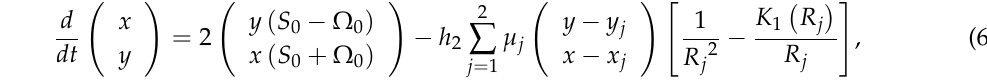
− 0.015; ( b ) − 0.007; 0 : ( a )